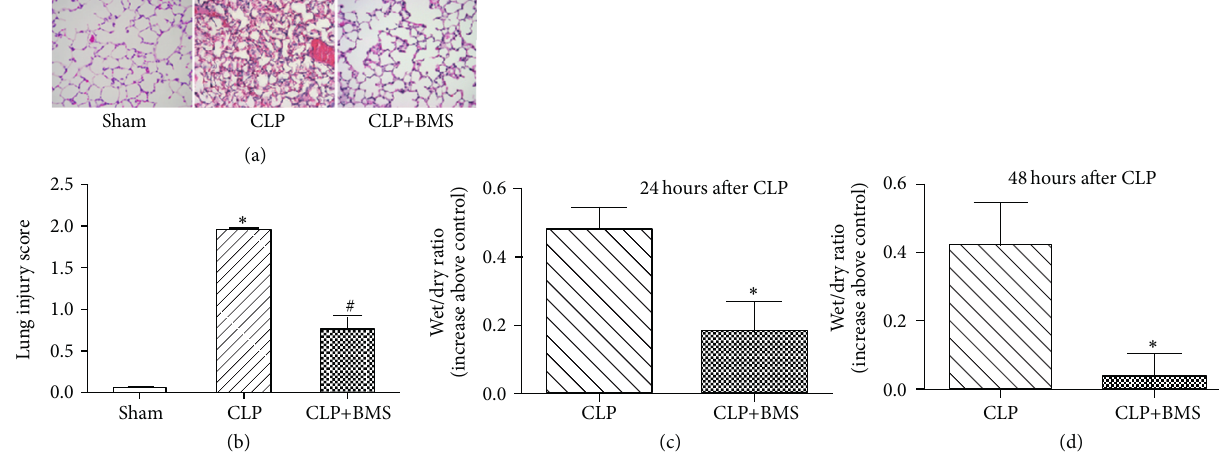
Figure 4: NF- 𝜅 B inhibition blocks lung injury and reduces apoptosis after CLP. (a) and (b) Histological evaluation of lung injury on H&E stained lung sections at 48 hours after CLP, ∗ 𝑃 < 0.05 for CLP versus sham laparotomy controls (Ctrl); # 𝑃 < 0.05 for CLP+BMS versus CLP. (c) and (d) Lung edema as measured by wet/dry ratio at 24 and 48 hours after CLP, reported as increase above sham laparotomy controls. 𝑁 = 5 per group; ∗ 𝑃 < 0.05 for CLP+BMS versus CLP. Results are presented as mean ±